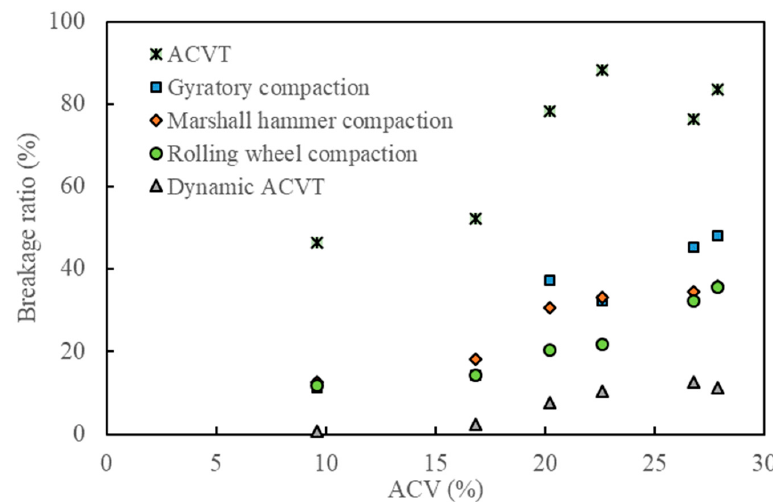
Figure 12. Effect of ACV on the breakage ratio under various loading methods.